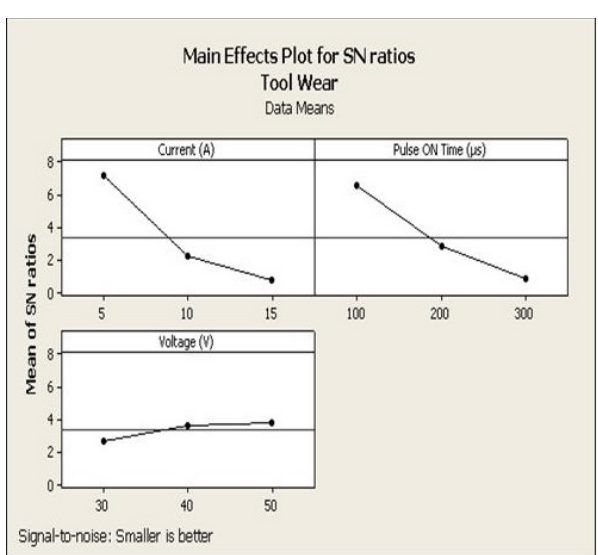
Figure 4. Main effects plot for SN ratios - TWR-EDM.